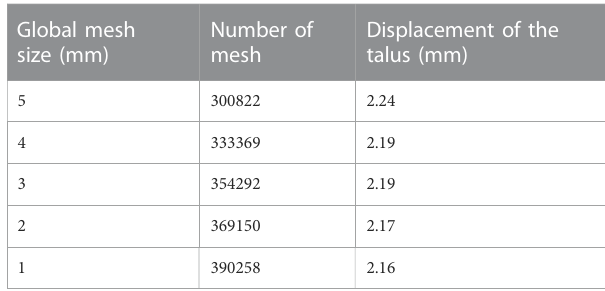
TABLE 3 The results of mesh sensitivity analysis.